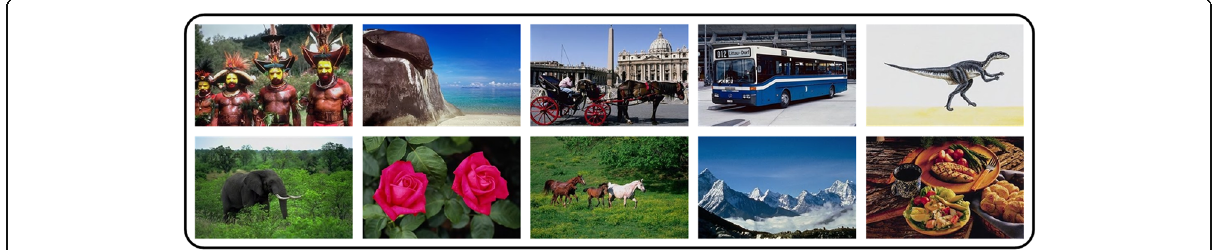
Fig. 6 Sample images associated with image benchmark of the Corel-1K